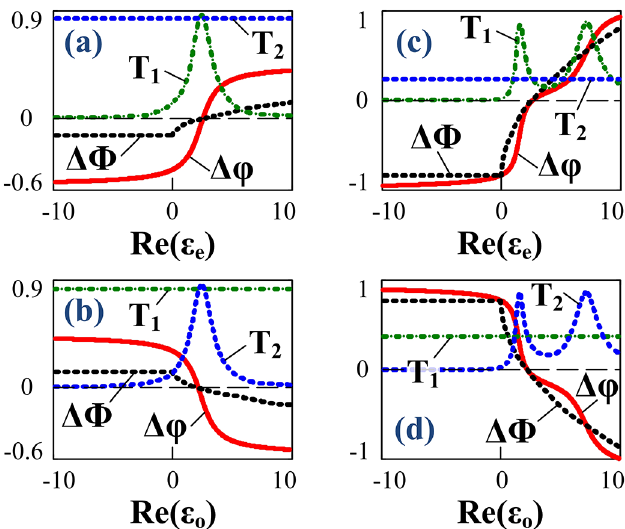
Fig. 12. Dependences of PSD D ’ , DF , energy transmission coef fi cients T 1,2 of waves 1, 2 on parameters Re ð e 1 ; 2 ð Þ e Þ (b, d) for various materials of layers 1, 3 and anisotropic materials of the main layer. The values of parameters are: